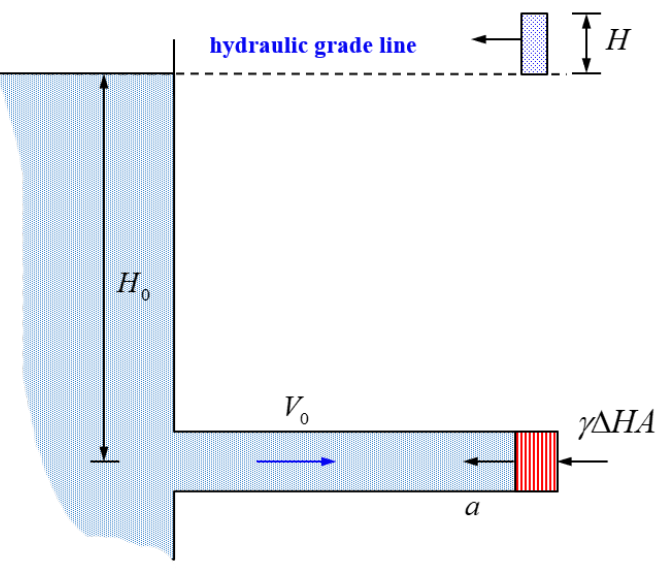
Figure 1. The fluid movement state in the pipe after the valve is suddenly closed (ignoring friction)